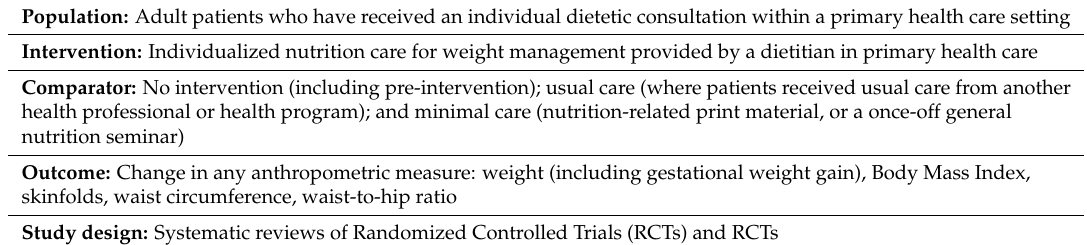
Table 1. Study selection criteria for the systematic review of the effectiveness of dietitians in weight